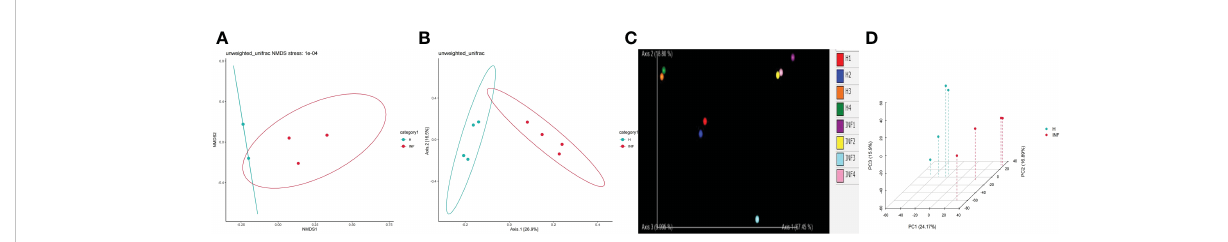
FIGURE 3 Beta diversity analysis between yak groups. (A) NMDS, (B) PCoA, (C) Qiime 2 b , (D) PCA.